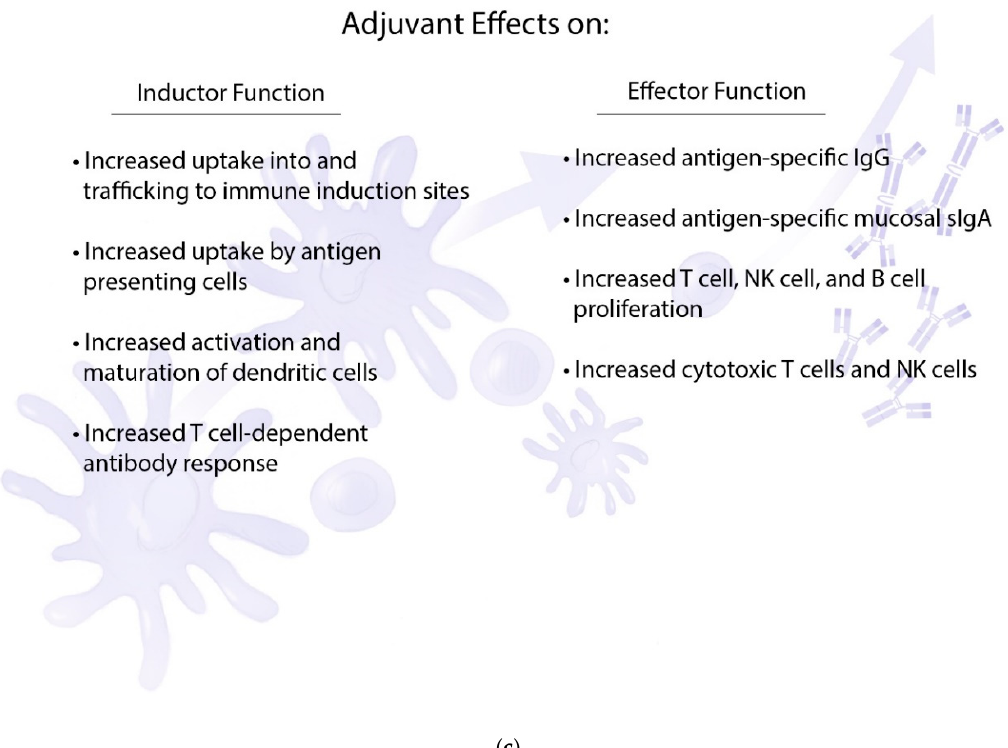
Figure 1. Lactic acid bacteria (LAB) interactions with the mucosa and mucosal immune system. ( a ) Endogenous LAB mucosal interactions. LAB possess the ability to bind to mucus ( 1 ), epithelial cells, and microfold (M) cells ( 2 ) allowing for uptake into mucosal associated lymphoid tissue (MALT) and tra ffi cking to local lymph nodes ( 4 ) [24–26]. The interactions of LAB with the epithelium can induce epithelial defenses such as the secretion of β -defensin ( 3 ) [27,28]. LAB can activate macrophages ( 8 ) and dendritic cells (DCs) ( 5 ), which can tra ffi c phagocytosed LAB to local immune induction sites ( 4 ) [29–32]. LAB also induce e ff ector immune responses such as polarization of naïve T cells to Th1, Th2, and Treg cells ( 6 ) and humoral responses such as B cell proliferation, class switching to IgG and IgA, induction of long-lived plasma cells, and induction of the mucosal homing integrin α 4 β 7 ( 7 ) [33,34]. ( b ) LAB mucosal adjuvant strategies. ( 1 ) LAB secretion of pro-inflammatory cytokines such as IL-12, IL-1 β , and IL-2 activates T cells, NK cells, and B cells, induces epithelial cell adhesion molecule expression, and promotes tra ffi cking of LAB to local lymph nodes. ( 2 ) LAB surface expression of the epithelial cell adhesion molecules InlA and / or FnBPA promotes binding and uptake of LAB by epithelial cells, delivery of eukaryotic expression plasmid, and secretion of protein. ( 3 ) LAB surface expression of DC-binding peptides results in targeting, increased uptake, and activation of DCs as well as tra ffi cking to local immune induction sites. ( 4 ) Surface expression of LT or CT B subunit results in LAB binding to gangliosides on the surface of epithelial cells and DCs. Co-delivery of full toxins or CT / LT A subunit results in a pro-inflammatory response. ( 5 ) Surface-expressed flagellin, a TLR5 ligand, induces cytokine production by epithelial cells and direct activation of DCs. ( 6 ) LAB secretion of RANKL results in increased M cells and uptake of LAB into MALT. ( c ) Review of the e ff ects of adjuvants on the immune response to LAB mucosal vaccination. LAB: Lactic acid bacteria; DC: Dendritic cell; M φ : Macrophage; MALT: Mucosal-associated lymphoid tissue; pIgA: Polymeric immunoglobulin receptor; sIgA: Secretory IgA; NK cells: Natural killer cells; M cells: Microfold cells; TLR: Toll-like receptor; RANKL: Receptor activator of nuclear factor kappa-B ligand; InlA: Listeria monocytogenes internalin A; FnBPA: Fibronectin-binding protein A; CT: Cholera toxin; LT: E. coli heat-labile